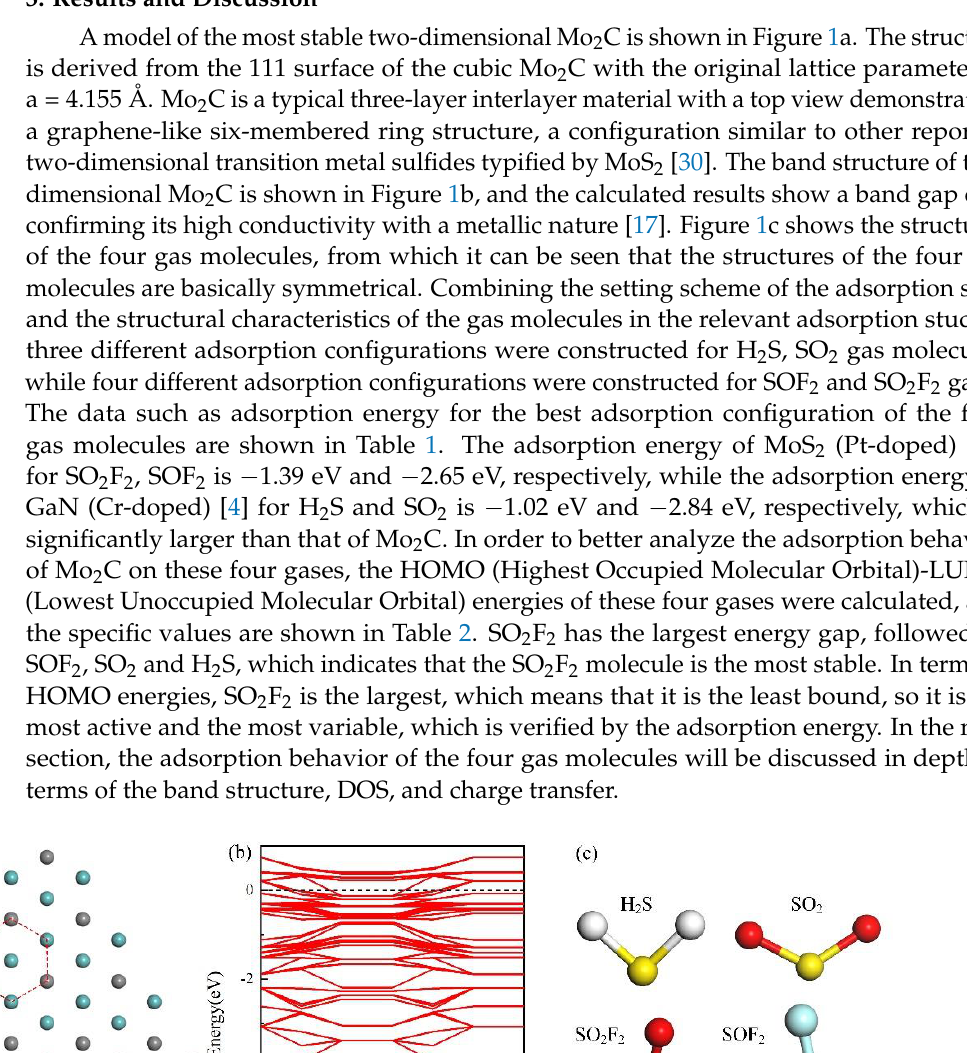
Table 2. HOMO/LUMO energies of the four gas molecules.